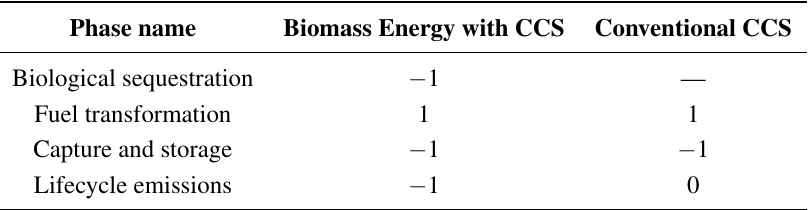
Table 4. Comparing lifecycle emissions of conventional CCS and